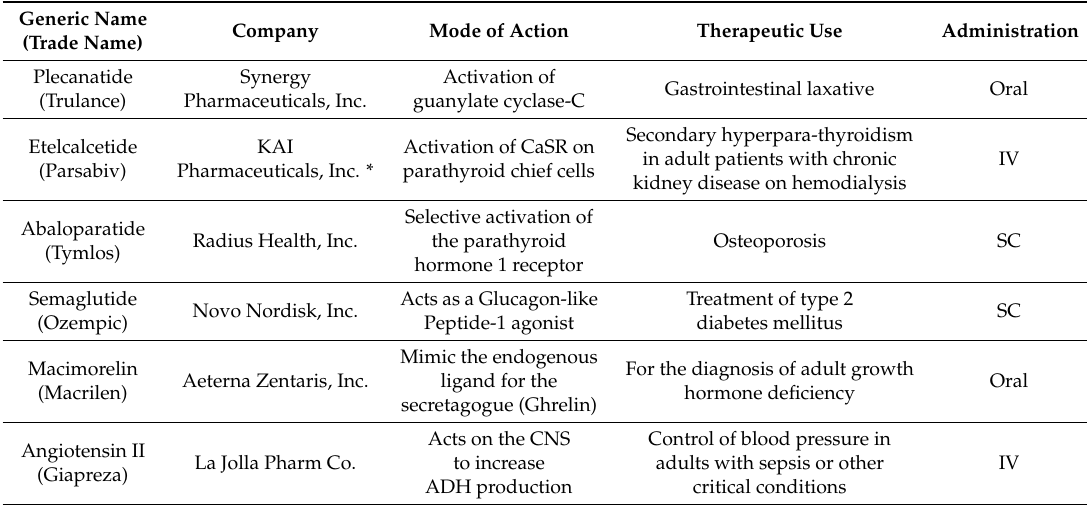
Table 1. Summary of the peptides approved by the FDA in